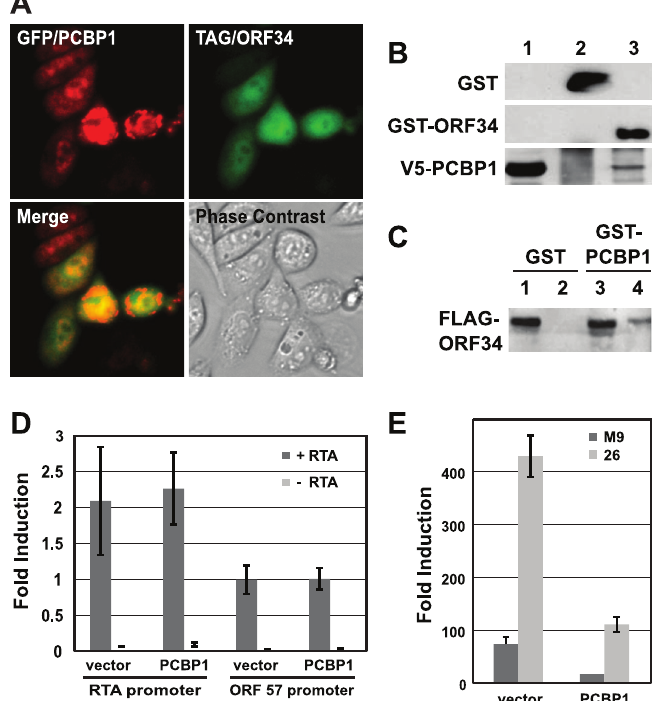
Figure 7. PCBP1 interacts with ORF34 in mammalian cells and negatively regulates late gene expression. (A) Co-localization of PCBP1 and ORF34 in 3T3 cells. Expression plasmids encoding GFP-tagged PCBP1 and FLAG-tagged ORF34 were co-transfected into NIH 3T3 cells. GFP-PCBP1 was visualized by direct fluorescence. FLAG-ORF34 was detected by immunofluorescence assays with anti-FLAG-M2 antibody and Alexa Fluor 594- conjugated anti-mouse IgG antibodies. Panel 1 shows GFP-tagged PCBP1 (green); panel 2, FLAG-ORF34 (red); panel 3, merged image; panel 4, phase contrast image of same field; panel 5, DAPI-stained nuclei. (B) Co-purification of GST-ORF34 and V5 epitope-tagged PCBP1. GST and GST-ORF34 were expressed in BL21 cells and purified with glutathione beads. Extracts from cells that over-expressed V5-PCBP1 were incubated with either GST or GST- ORF34 bound beads. Lane 1, input amount of V5-PCBP1; lane 2, GST pull-down of V5-PCBP1; lane 3, GST-ORF34 pull-down of V5-PCBP1. (C) Co- purification of GST-PCBP1 and FLAG epitope-tagged ORF34. HEK293T cells were transfected with expression plasmids encoding FLAG-ORF34 and either GST or GST-PCBP1 and then infected with MHV-68. Lysate were incubated with glutathione beads and subjected western blot analysis with anti-FLAG antibodies. Lanes 1 and 3, input amount of FLAG-ORF34; lanes 2 and 4, GST and GST-PCBP1 pull-down of FLAG-ORF34, respectively. (D) Over-expression of PCBP1 did not affect expression from early MHV-68 promoters. Reporter constructs encoding the early viral promoters RTA and ORF57 were co-transfected with parental vector pHB/attR (vector) or pHB/PCBP1 plasmid, with or without the pCMV/RTA plasmid. Luciferase activity was measured at 24 h post transfection. (E) Over-expression of PCBP1 inhibited expression from late MHV-68 promoters. Reporter constructs encoding the late viral promoters M9 and ORF26 were co-transfected with parental vector pHB/attR (vector) or pHB/PCBP1 followed by MHV-68 infection at an MOI of 0.5 in 293T cells. Luciferase activity was measured at 24 h post infection.